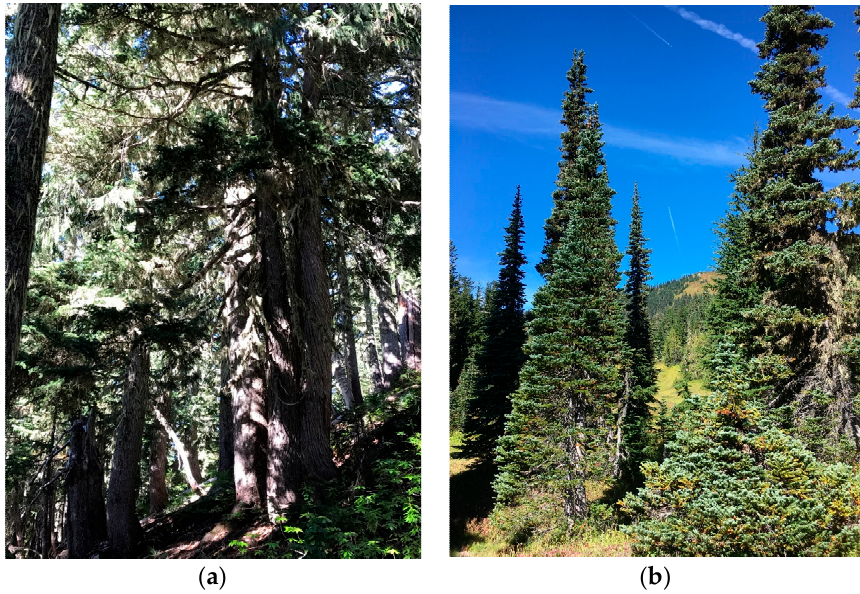
Figure 3. Closed-canopy forest where A. amabilis , T. mertensiana , and C. nootkatensis co-occur ( a ) and open meadow where A. lasiocarpa has established ( b ) at the sampling locations on the northwest side of Mt. Rainier.